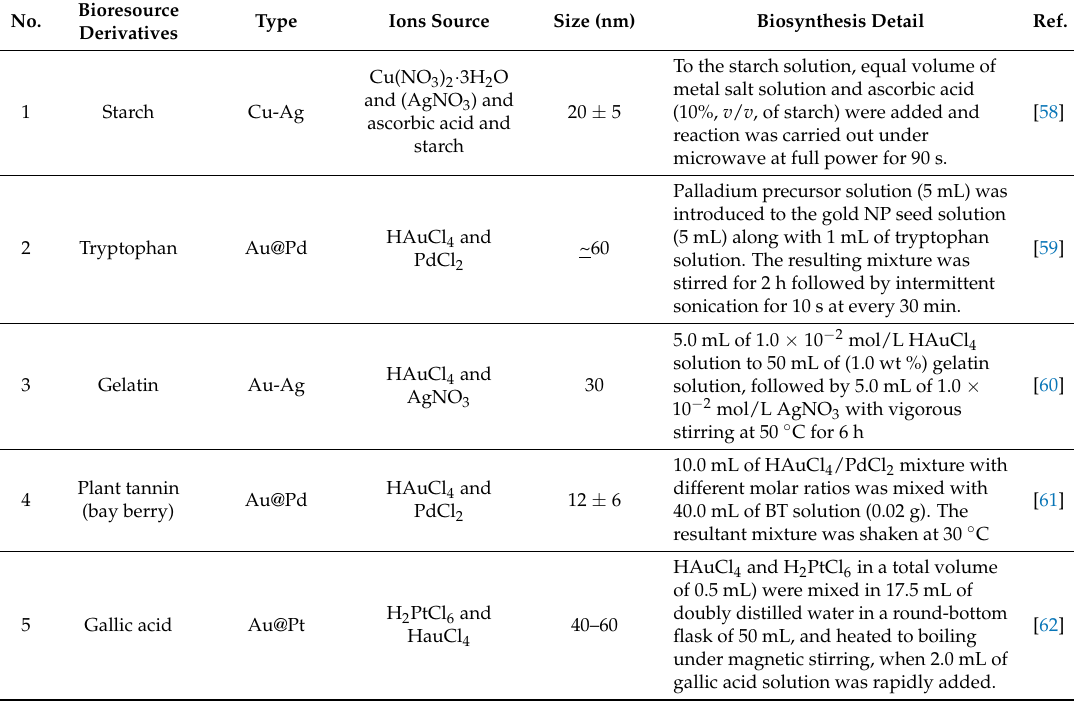
Table 3. Greener synthesis of hybrid nanoparticles using natural